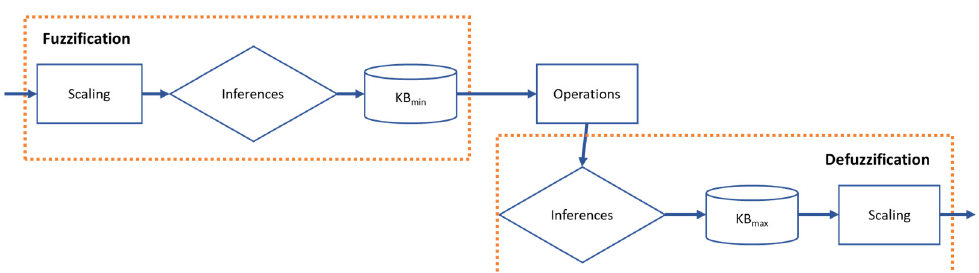
Figure 1. Representation of the structure of a Fuzzy Logic Controller (FLC) with two main compo- nents. First, the fuzzification: scaling (conversion of data from binary to decimal), rules of inference, and knowledge base composition min (KB min ) according to the input. Then, defuzzification: rules of inference, knowledge base max (KB max ), and scaling.